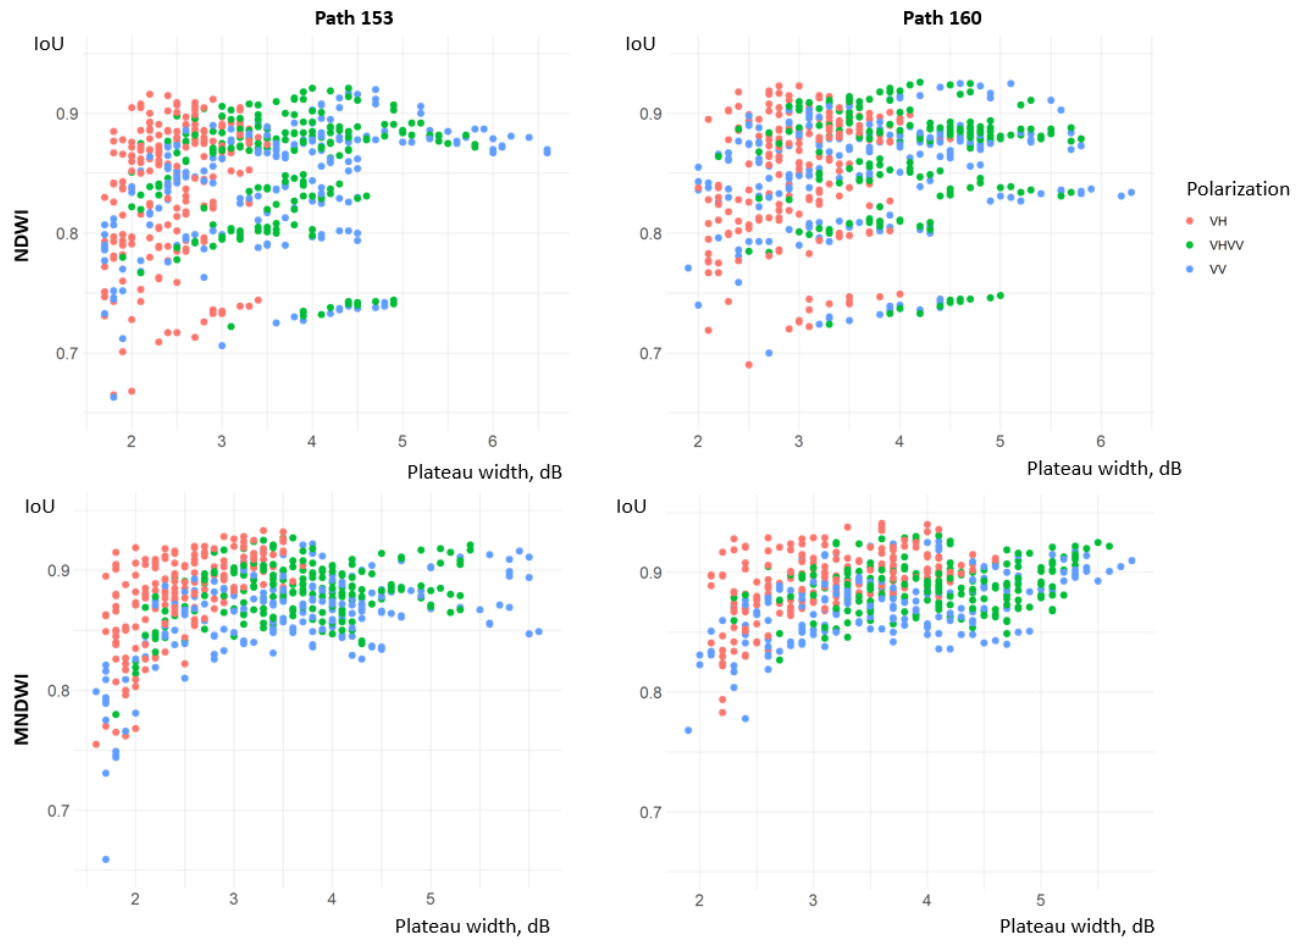
Figure 9. Scatterplots of IoU values versus plateau